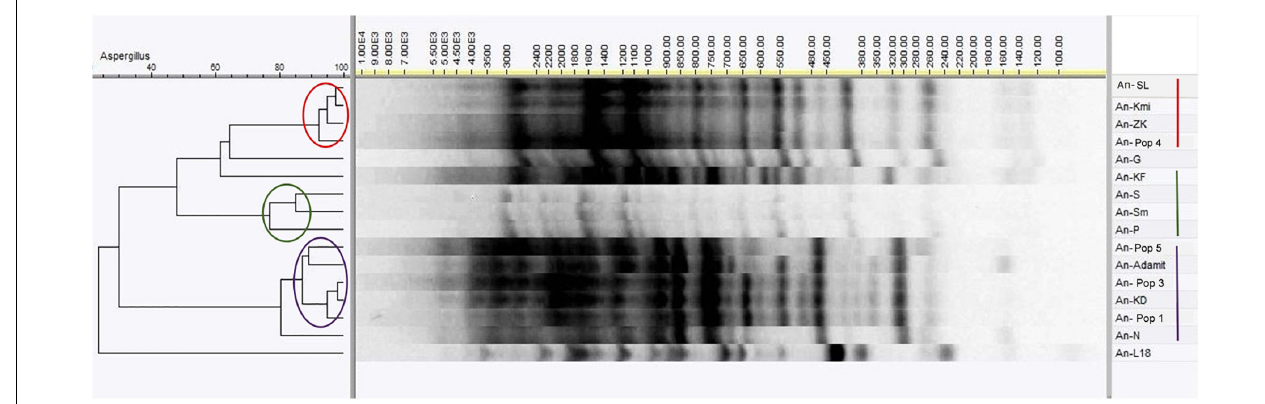
FIGURE 4 | RAMP analysis of Aspergillus niger environmental isolates using Pearson correlation and UPGMA clustering.